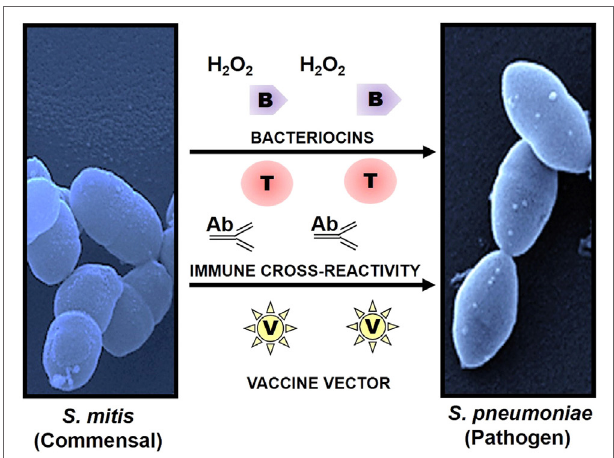
FiGURe 1 | Use of commensals as a prophylactic strategy against respiratory pathogens. Commensals showing high homology with pathogenic species have the potential to induce cross-reactive immune responses and to act as a vaccine delivery system. Commensal Streptococcus mitis induces cross-reactive antibody (Ab) and T cell (T) responses against pathogen Streptococcus pneumoniae . Production of bacteriocins (B) and hydrogen peroxide (H 2 O 2 ) by S. mitis elicits direct protection against pathogens like S. pneumoniae . In addition, S. mitis has been used as a potent vector (V) for delivery of heterologous bacterial and viral antigens, which confers robust and antigen-specific immunity against respiratory infections. Scanning electron microscopy images of S. mitis NCTC12261 (left), and S. pneumoniae TIGR4